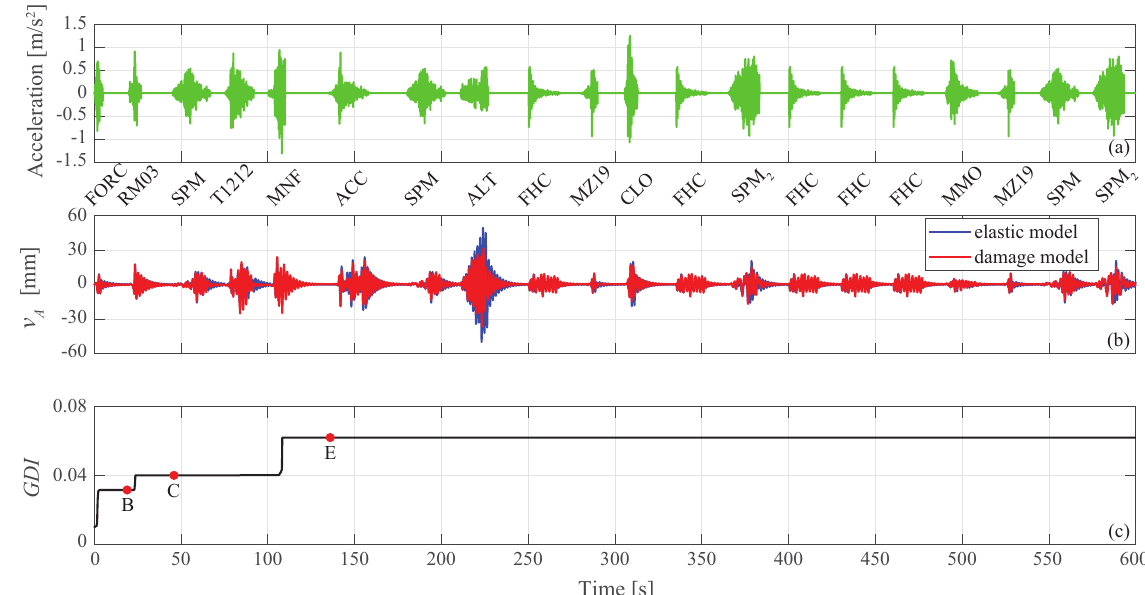
Figure 26. Seismic sequence: ( a ) input ground acceleration, ( b ) elastic and damage responses of the equivalent pier in terms of displacement of point A, ( c ) evolution of the GDI .